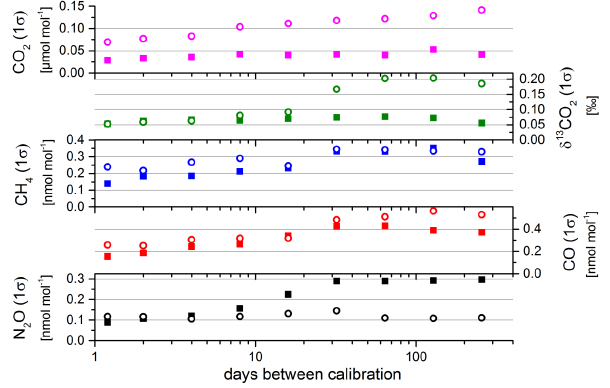
Fig. 10. Calibration frequency test. 1 σ standard deviation of the target gas measurements as a function of days between calibrations. Figure 10. Calibration frequency test. 1σ standard deviation of the target gas measurements as 4 Open symbols represent less-stable instrument conditions with sam- a function of days between calibrations. Open symbols represent less stable instrument 5 ple pressure variations (1 σ) of more than ± 7hPa. Filled symbols conditions with sample pressure variations (1σ) of more than ±7 hPa. Filled symbols relate to 6 relate to stable conditions with sample pressure variations (1 σ) of stable conditions with sample pressure variations (1σ) of less than ±2 hPa. 7 less than ± 8